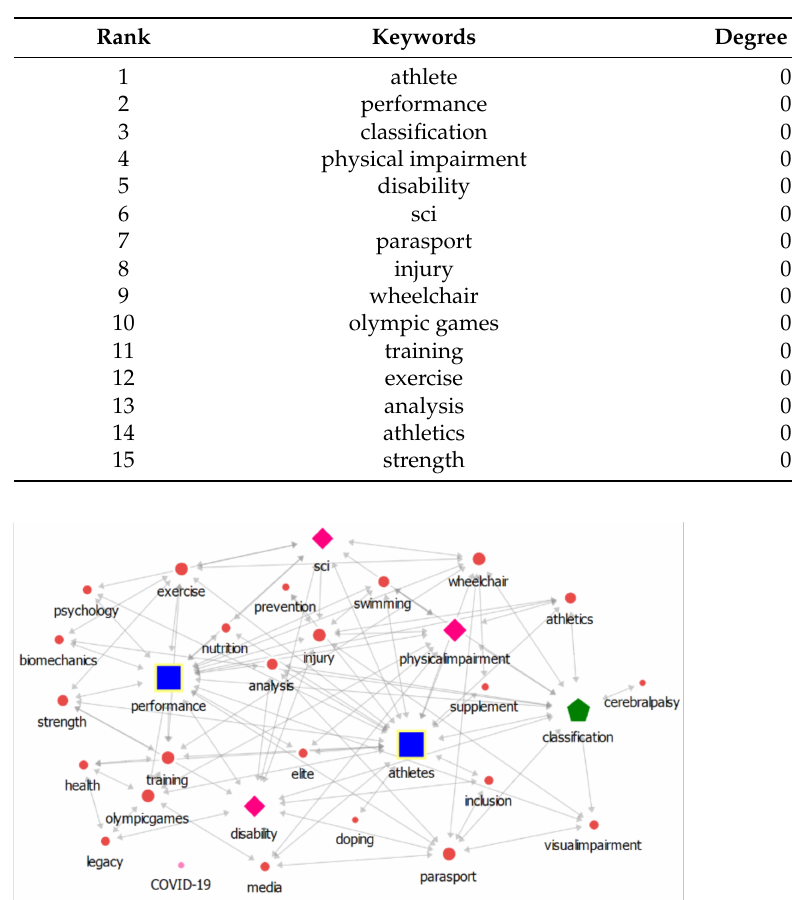
Figure 4. KNA chart of entire studies related to the